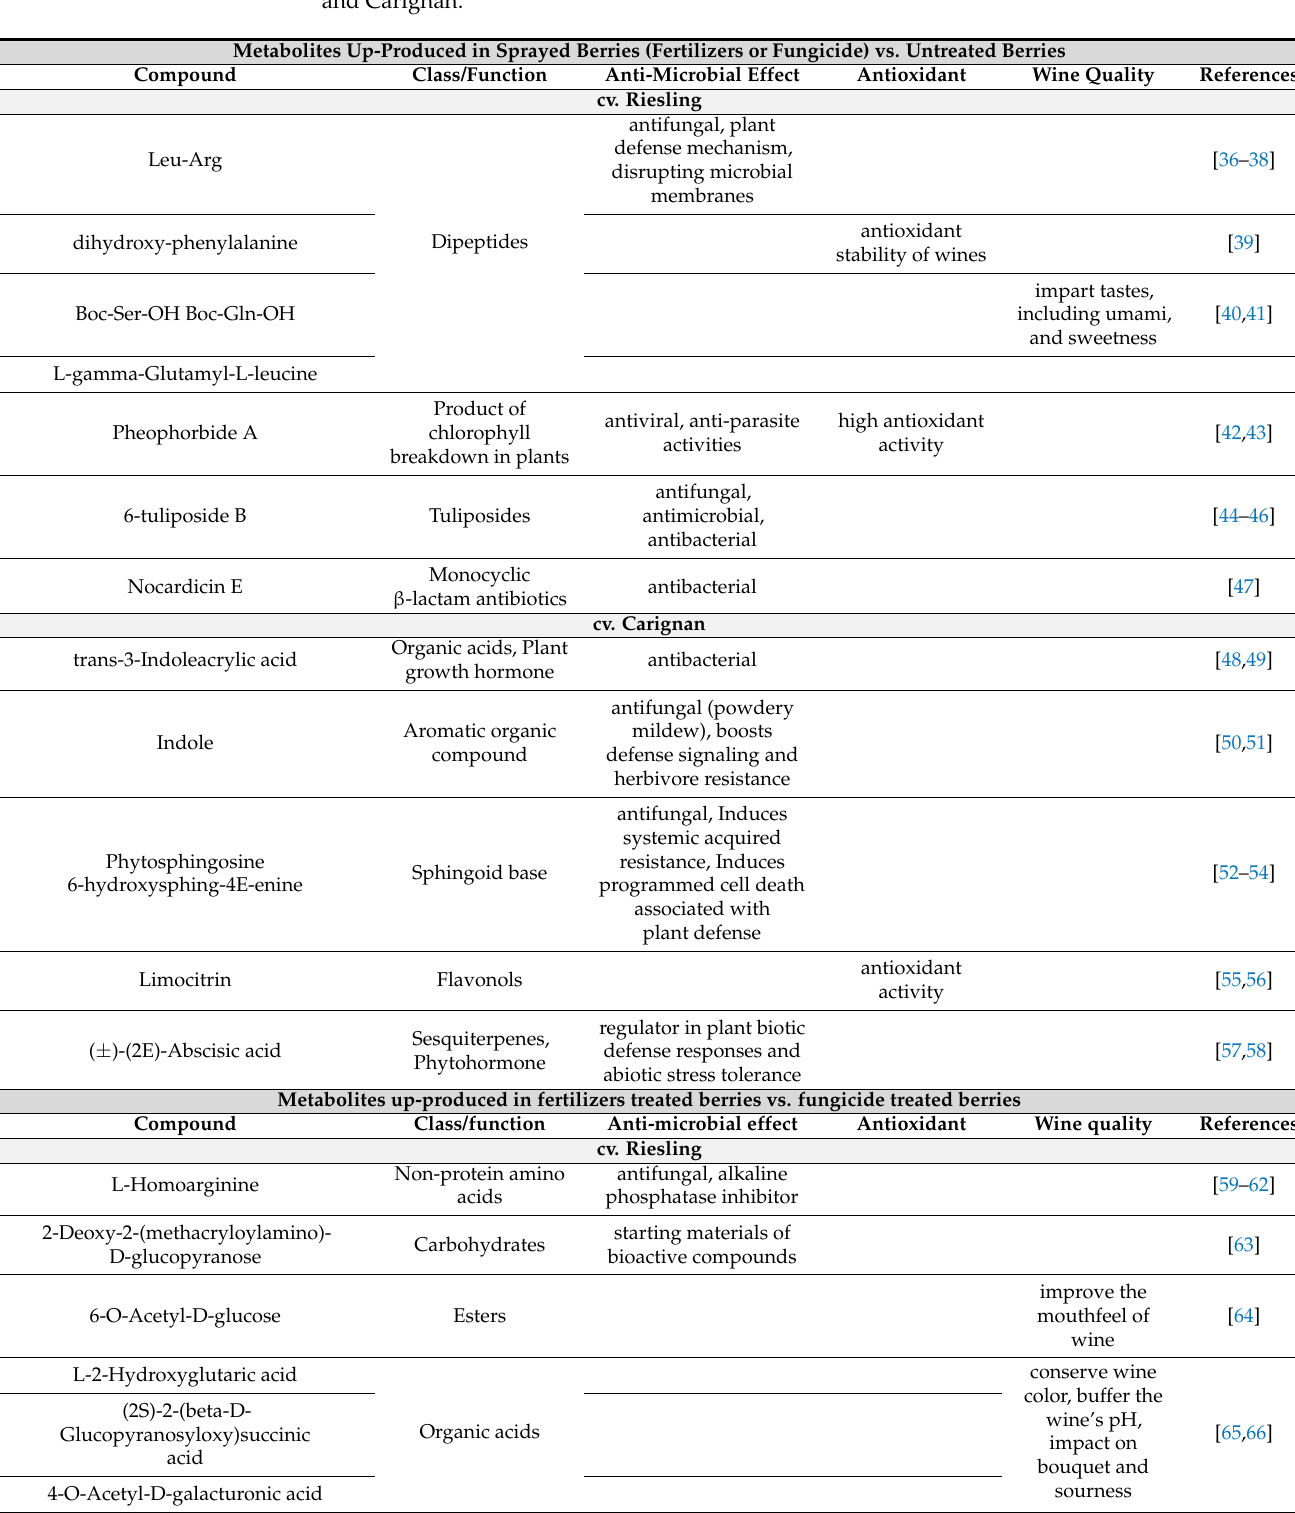
Table 5. List of significantly up-produced metabolites in grapes treated with fertilizers or fungi- cide and their characteristics. Colored rows differentiates between analyses and cultivars Riesling and